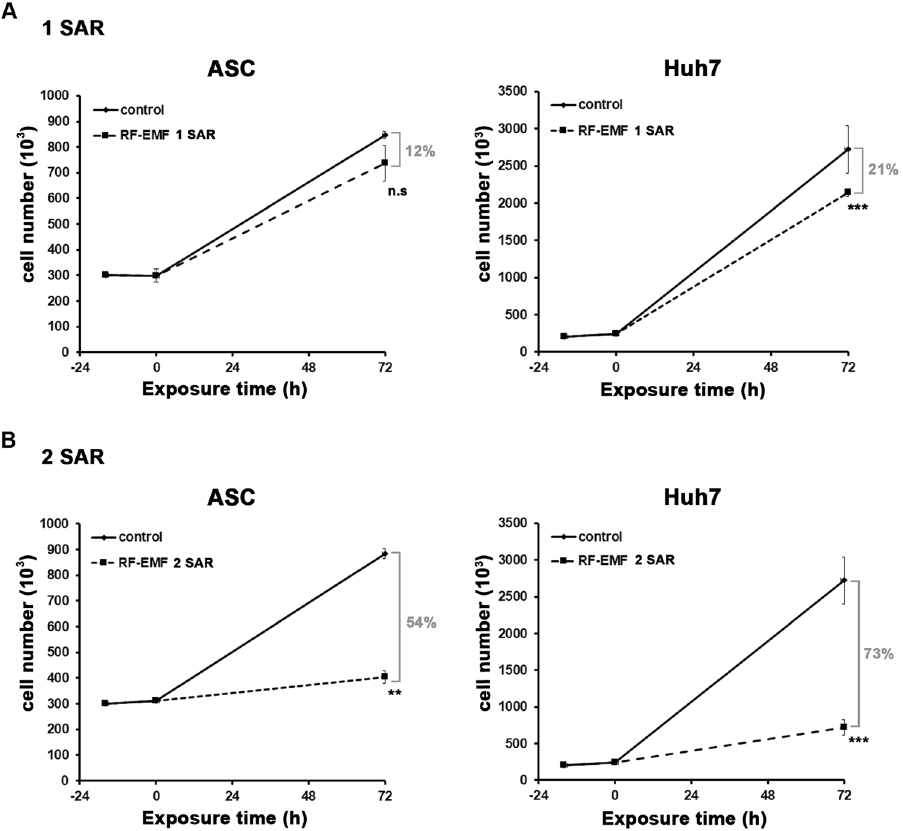
Figure 3. Continuous exposure to 1.7 GHz LTE RF-EMF decreased ASC and Huh7 cell proliferation. ( A,B ) ASCs and Huh7 cells prepared as described in Materials and Method were exposed to 1.7 GHz LTE RF-EMF for 72 h at 1 SAR ( A ) or 2 SAR ( B ). The sham control cells were incubated for 72 h without RF-EMF exposure. After the exposure, cells were collected, and counted with a cell counter (Nexcelom Bioscience). Three independent experiments were performed and the cell number was plotted as mean ± S.D. P < 0.01( ** ), P < 0.001( *** ), and P > 0.05 (non-significant,